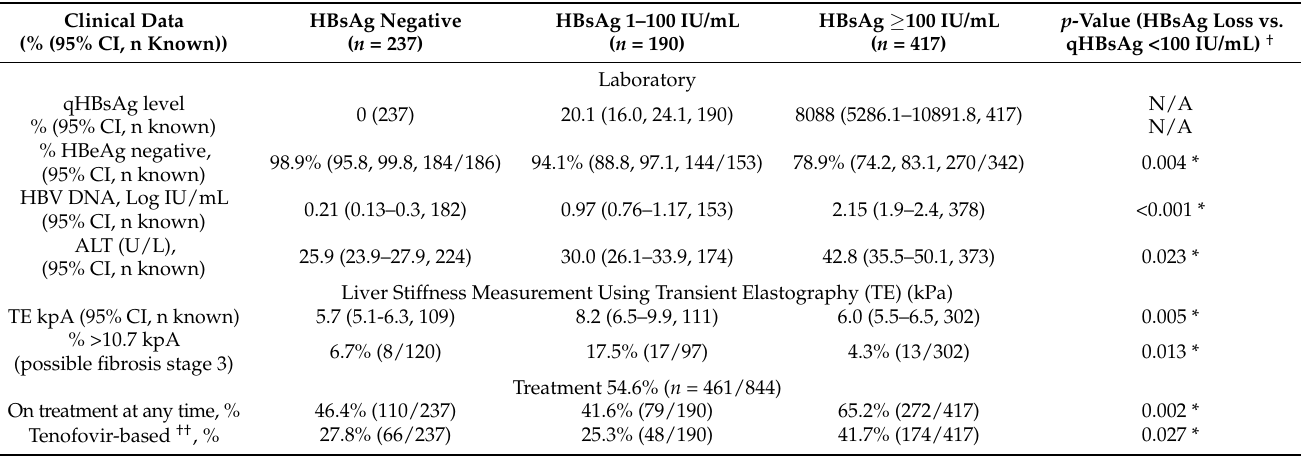
Table 2. Virological, biochemical, liver stiffness measurement (LSM), and antiviral treatment data of CHB patients who cleared HBsAg vs. those with low qHBsAg (<100 IU/mL) or with qHBsAg >100